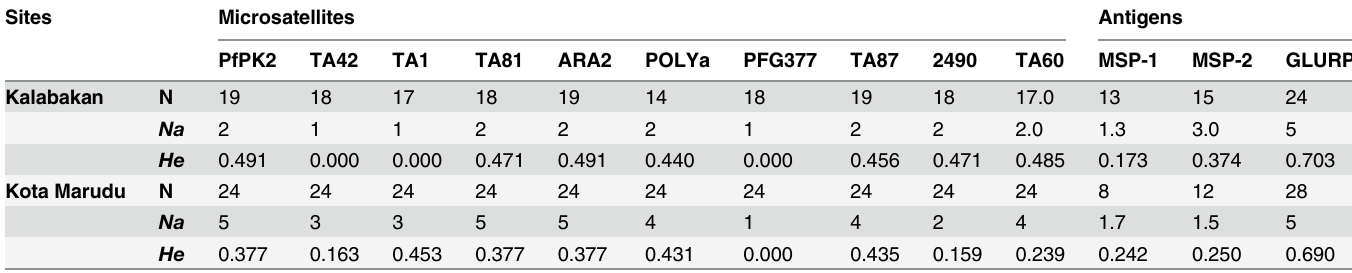
Table 7. The genetic diversity of P . falciparum populations by each neutral microsatellite and antigenic markers.